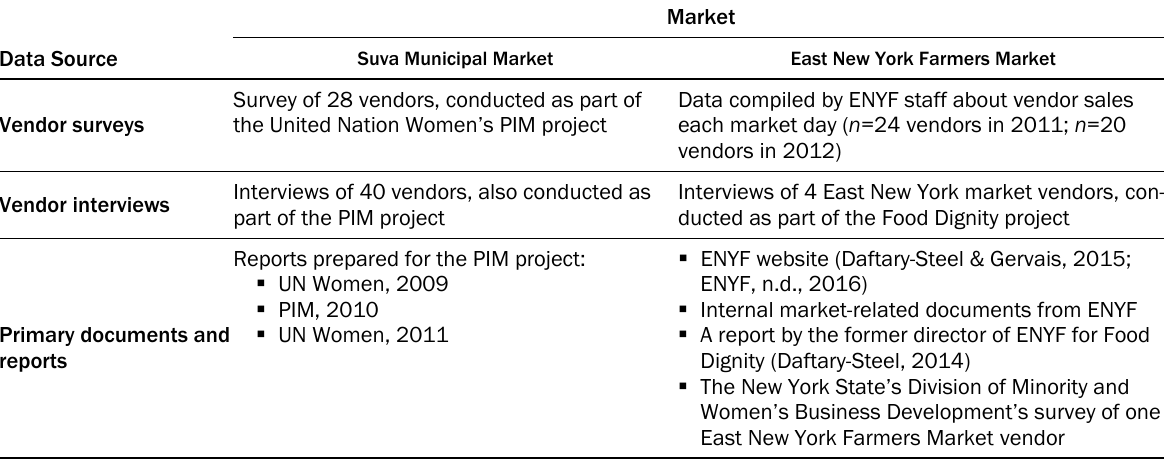
Table 1. Summary of the Three Data Types that Informed Our Case